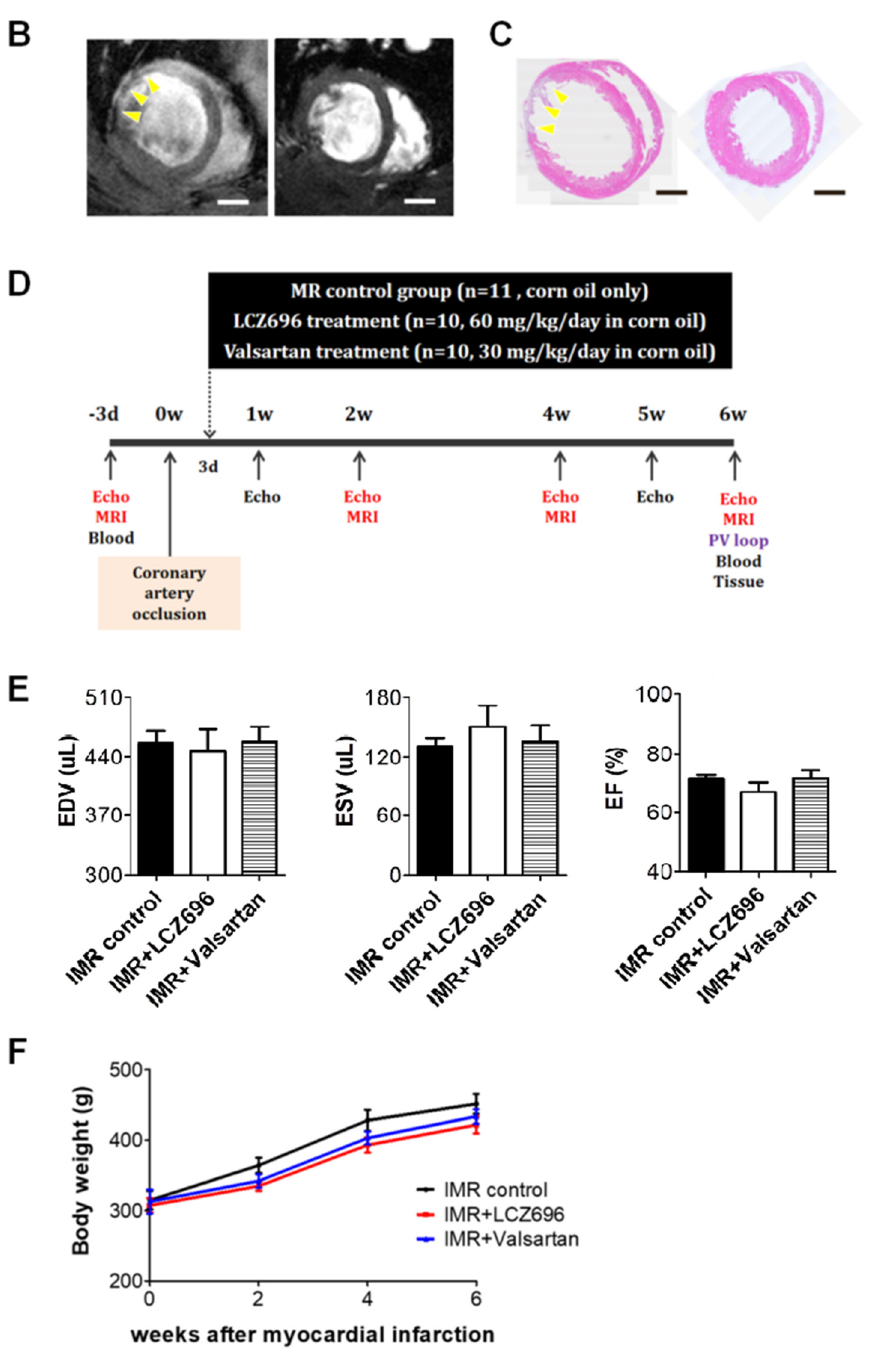
Figure 1. ( A ) Two weeks after left circumflex coronary artery occlusion was performed to induce myocardial infarction and ischemic mitral regurgitation (IMR), left ventricle size and function were evaluated by magnetic resonance imaging (MRI). ( B , C ) Representative images of cardiac MRI and immunohistochemical staining of hearts from the IMR model group (left) and sham control group (right). Arrows indicate infarcted area and myocardial fibrosis. Scale bar = 3 mm. ( D ) Schematic illustration of animal experiment protocol. Rats were randomly assigned to LCZ696 treatment (sacubitril/valsartan, 60 mg/kg/day in corn oil, n = 10), valsartan treatment (30 mg/kg/d in corn oil, n = 10), or corn oil only (MR control group; n = 11) group. ( E ) Comparison of parameters at 2 weeks after myocardial infarction among the three groups. ( F ) Comparison of serial changes in body weight among the three groups. EDV indicates end-diastolic volume; ESV, end-systolic volume; EF, ejection fraction; MRI, magnetic resonance imaging; IMR, ischemic mitral regurgitation. * p < 0.05 for differences from the sham group.